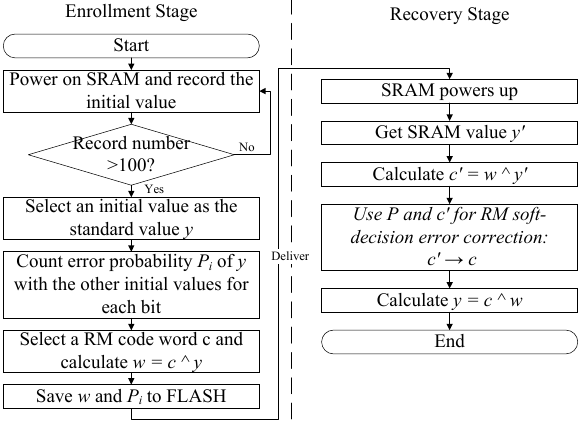
Figure 5. HDA soft-decision